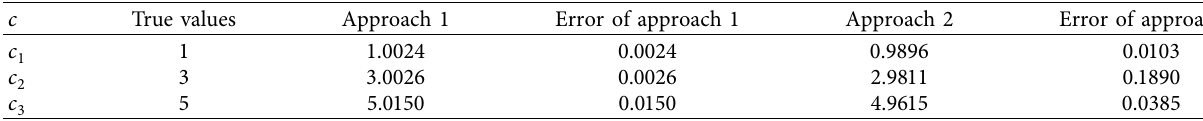
Figure 3: Plot for comparing the ANN solution and exact solution. (a) Exact solution, ANN and data. (b) Absolute error. Table 4: Comparison of the two approaches for Example 2.